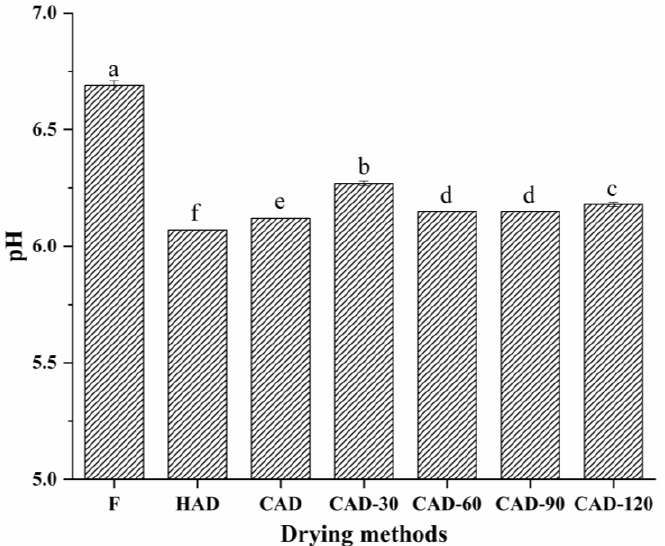
Figure 1. Changes in pH of semi-dried pufferfish fillets under different drying methods. Values with different superscripts are significantly different ( p < 0.05). F, fresh undried fillets; HAD, hot air drying; CAD, cold air drying; CAD-30, cold air drying for 30 min; CAD-60, cold air drying for 60 min; CAD-90, cold air drying for 90 min; CAD-120, cold air drying for 120